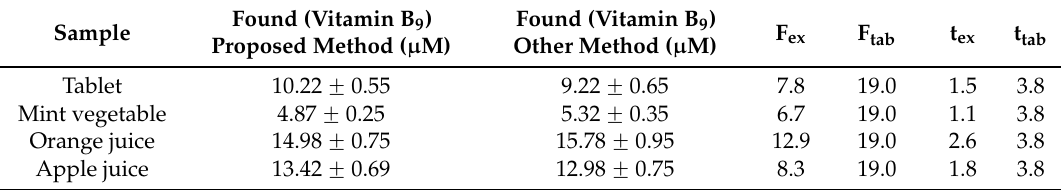
Table 3. Determination of vitamin B 9 in real samples (n =